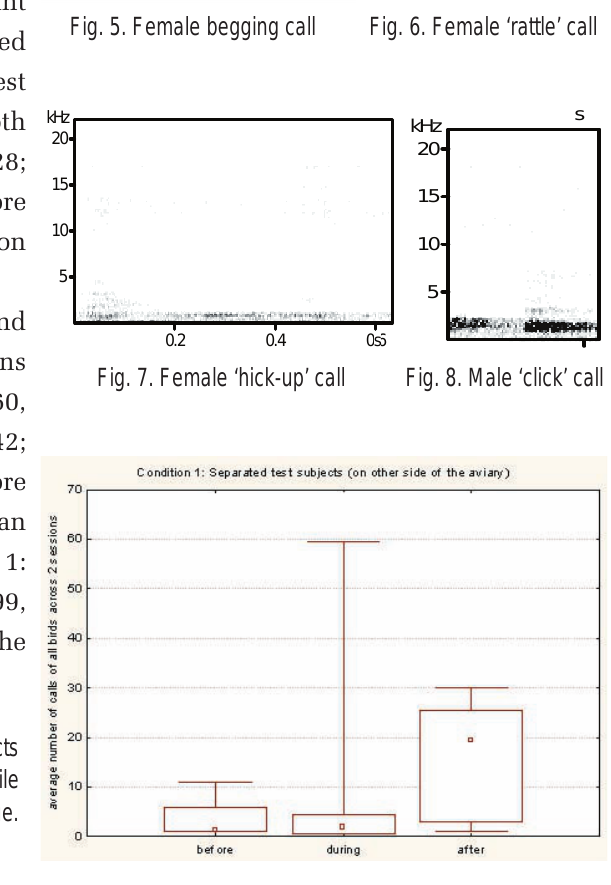
Fig. 5. Female begging call Fig. 6. Female ‘rattle’ call